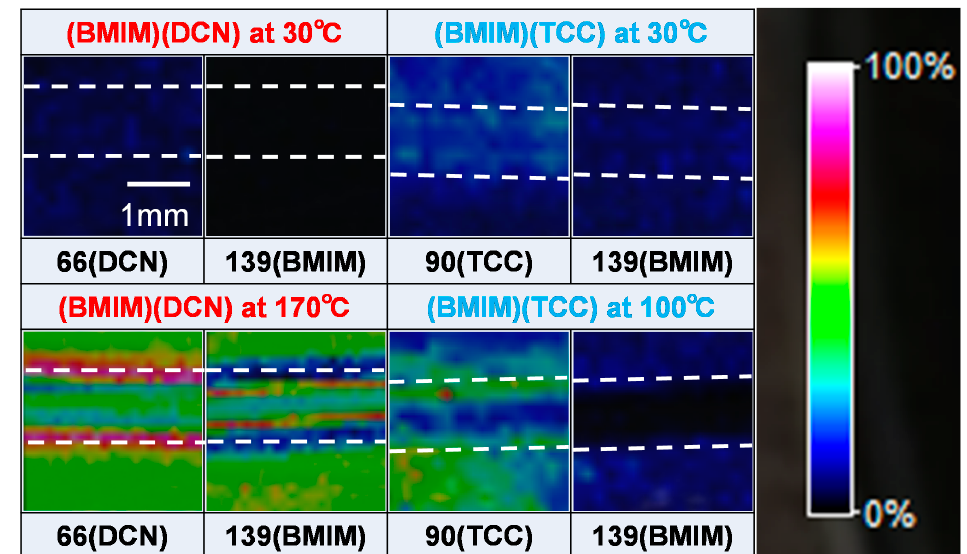
Figure 8. Mapping images of the ta-C film obtained using matrix-assisted laser desorption / ionization time-of-flight mass spectrometry (MALDI-TOF / MS).